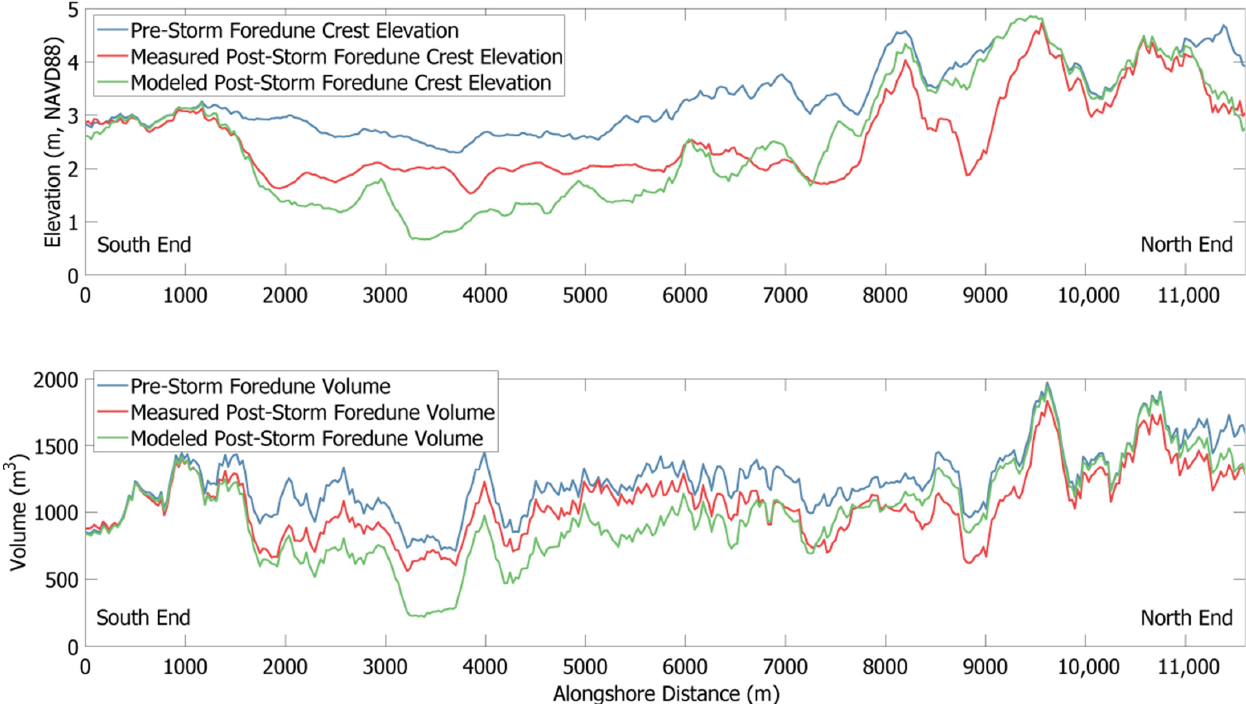
Figure 7. Comparisons between measured and modeled overwash extents for each simulation completed.